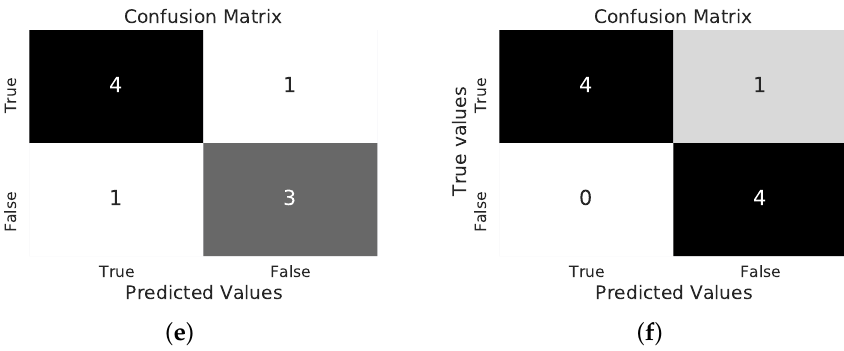
Figure 4. On the left, in ( a , c , e ), the prediction and classification results are only based on age. On the right, in ( b , d , f ), the prediction and classification results are based on age and the reconstruction error. In ( a , b ), linear regression results are shown. In ( c , d ), the classification results are shown. The regression in ( b ) and the classification in ( d ) are based on the optimal window size ∆ t = 60 min and the optimal 7th reconstruction error. In ( c , d ), the purple line is the mean ROC of the classification. The thin lines indicate all individual runs. In ( e , f ), confusion matrices for the classification of the test set are depicted. The test set contains nine samples, five of people with MCI and four of people with normal cognitive abilities, reflecting the overall